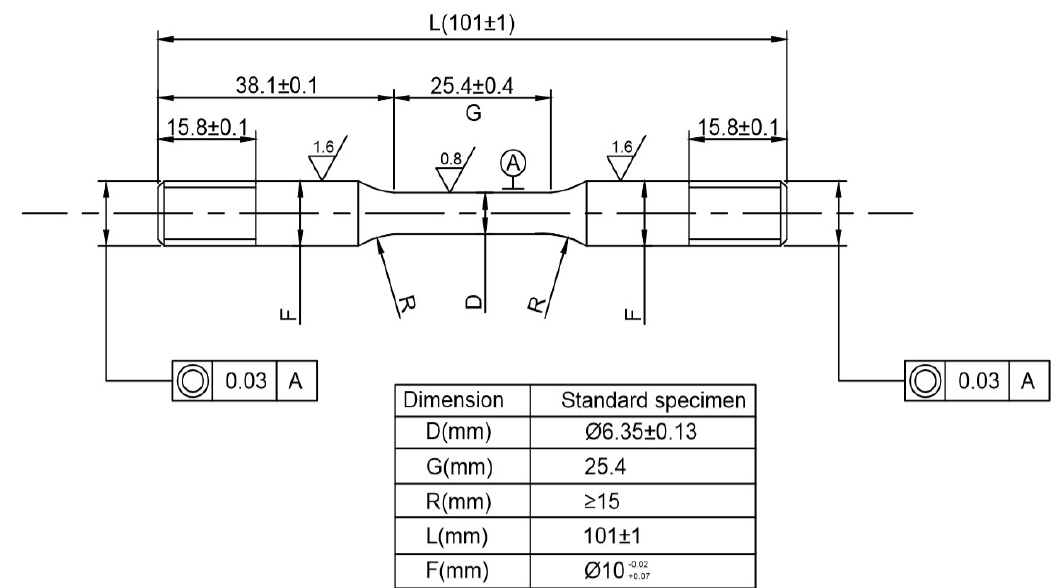
Figure 5. Dimensions of specimens for constant-load tests.